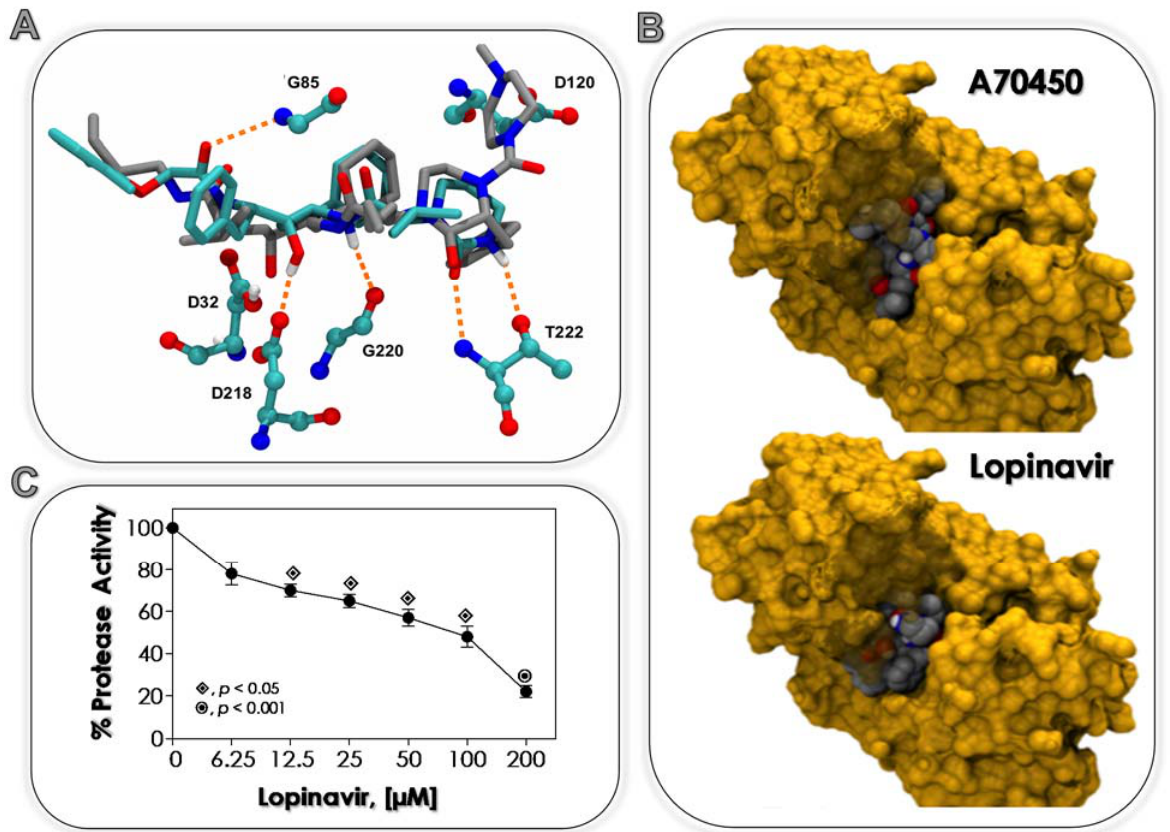
Figure 1. ( A ) Comparison of the geometries of the docked A70450 to C. albicans Sap2 catalytic site as determined experimen-